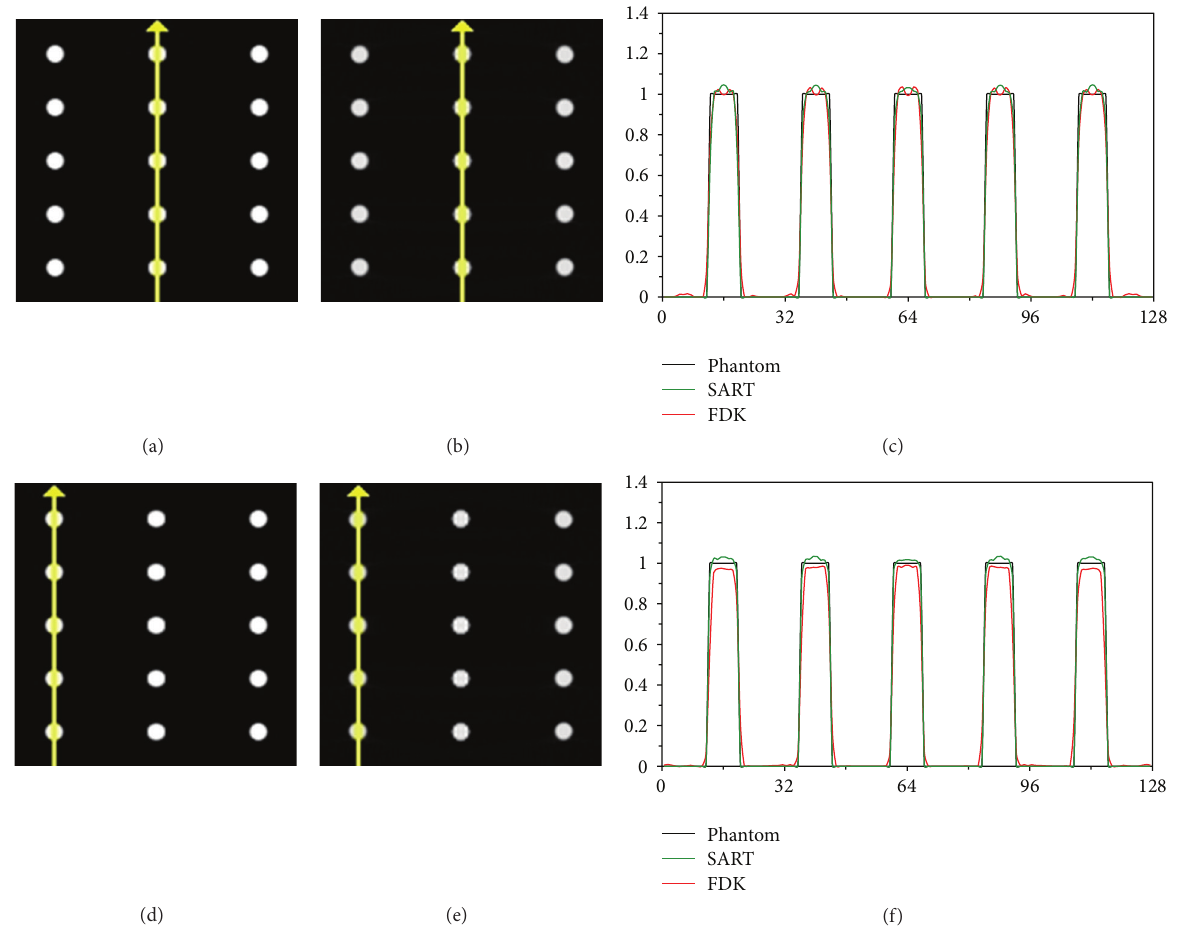
Figure 9: Coronal views of (a) SART and (b) FDK reconstructions with a (c) line profile taken through the center column. (d) SART and (e) FDK reconstructions with a (f) line profile taken through a side